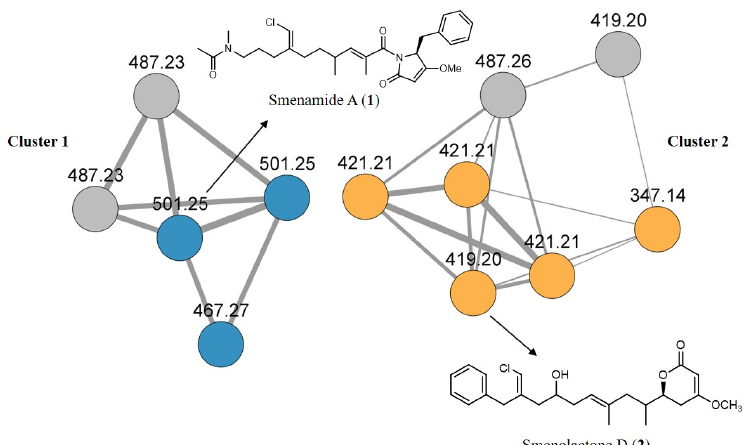
Figure 2. Molecular network obtained from the LC-MS/MS analyses of extracts from S. aurea . Edge thickness is relative to the cosine score. Cluster 1 represents smenamide analogues (in blue are known compounds and in light grey are unknown compounds), cluster 2 represents smenolactone analogues (in orange are known compounds and in light grey are unknown compounds).